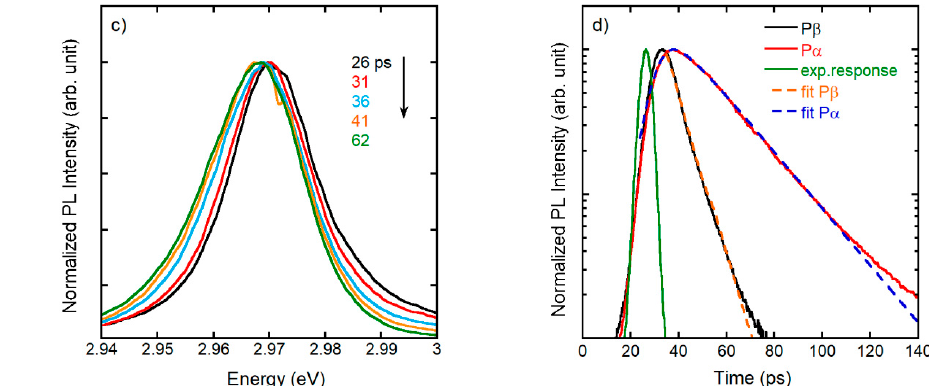
Figure 5. ( a ) Typical streak camera image of the time-resolved (TR) macro-PL at 14 K for sample A; ( b ) TR PL spectra extracted from a); ( c ) Normalized TR spectra showing the transfer of population from higher to lower energy states at increasing time delay; ( d ) PL decays (continuous line) extracted from ( a ) at peaks energy of P α (in red) and P β (in black) along with the experimental time response (in green). The fit functions (dashed lines) are shown superimposed to the experimental PL decays.